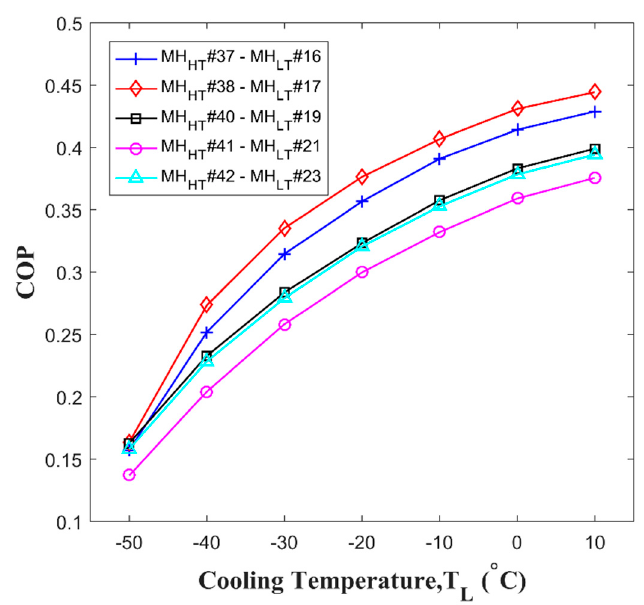
Figure 7. (cid:1829)(cid:1841)(cid:1842) (cid:3030)(cid:3042)(cid:3042)(cid:3039) of the optimized pairs. Each optimized hydride pair shows a different performance with a different objective cooling temperature, (cid:1846) (cid:3013)